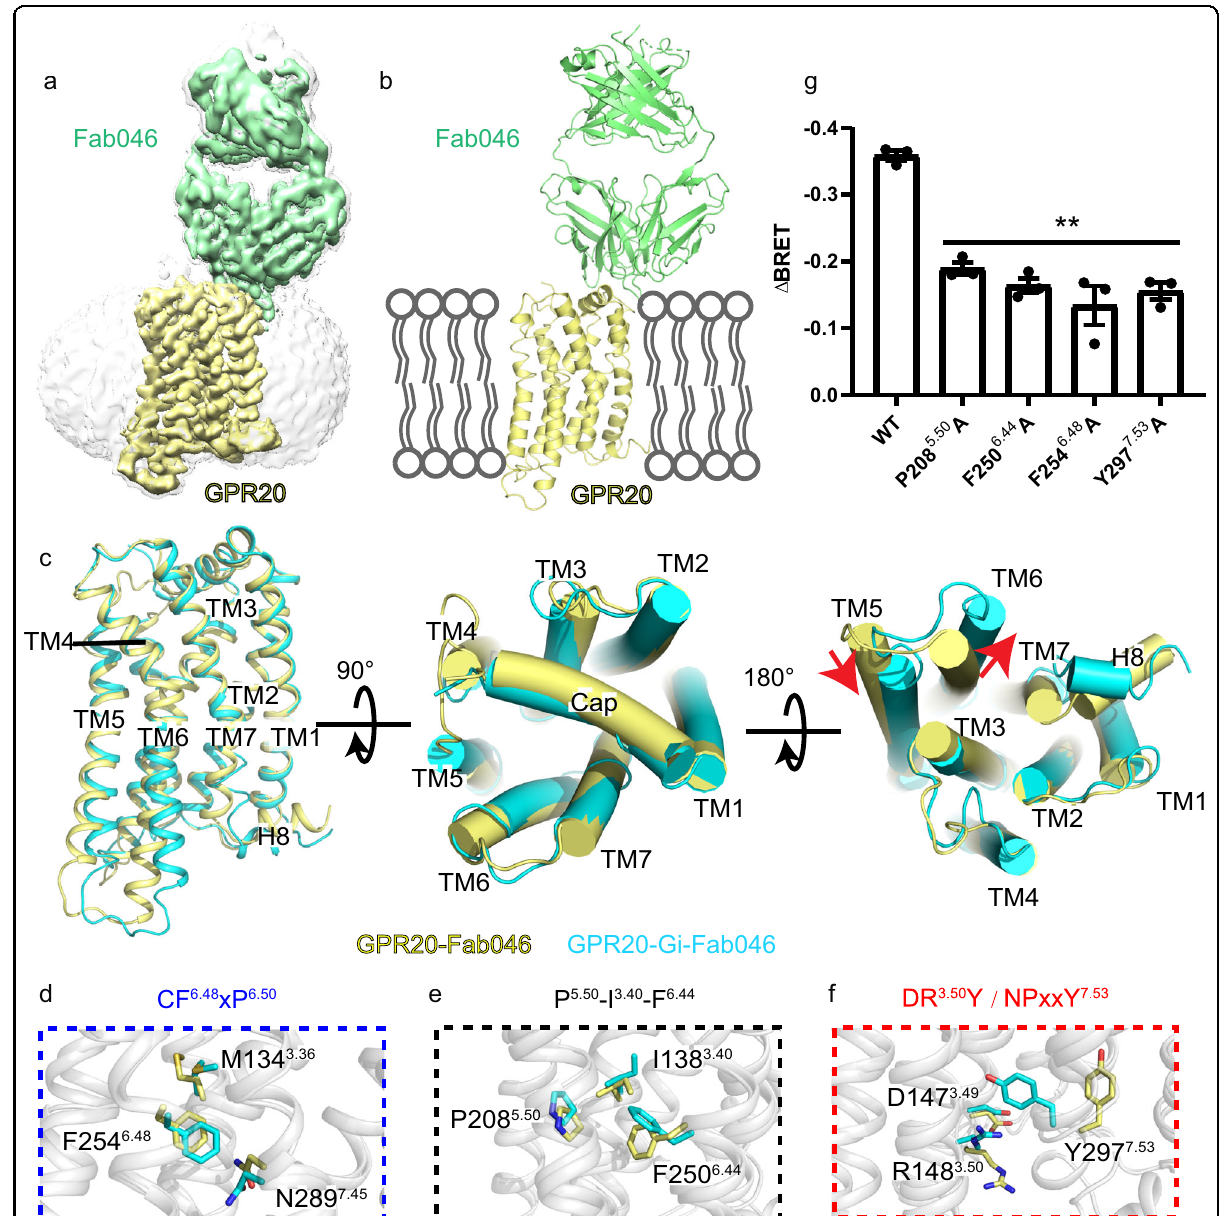
Fig. 4 Antibody-bound GPR20 structure. a , b Cryo-EM density map and atomic models of the GPR20-Fab046 structure. c Overlay between GPR20- Fab046 and GPR20-Gi-Fab046 structures in three representative views. Transmembrane helices TM1-TM7 and helix 8 (H8) are labeled. The movements of TM5 and TM6 on the intracellular side are highlighted as red arrows. d – f The conformational rearrangement of residues in conserved “ micro- switches ” upon Gi coupling: CF(W)xP, toggle switch, PIF, DRY and NPxxY motifs. g The effects of mutation in micro-switches are measured by BRET assay. Signi fi cance was determined by two-way analysis of variance (ANOVA) without repeated measures, followed by Dunnett ’ s post hoc test (** P < 0.01). Data are mean ± s.e.m. ( n = 3 independent biological